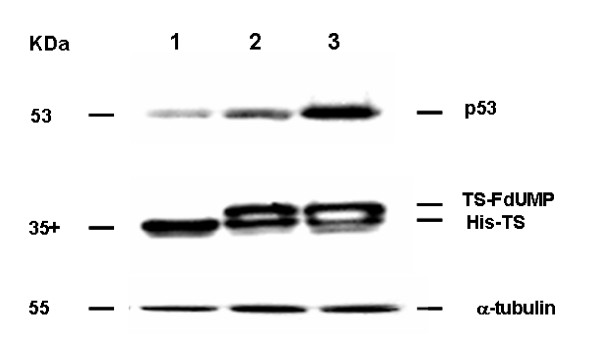
Effect of 5-FU on p53 and TS expression via Western immunoblot analysis. Equal amounts (25 μg) of protein extracts from both control and 5-FU treated HCT-C18 (TS+) cells were loaded and resolved with 10%